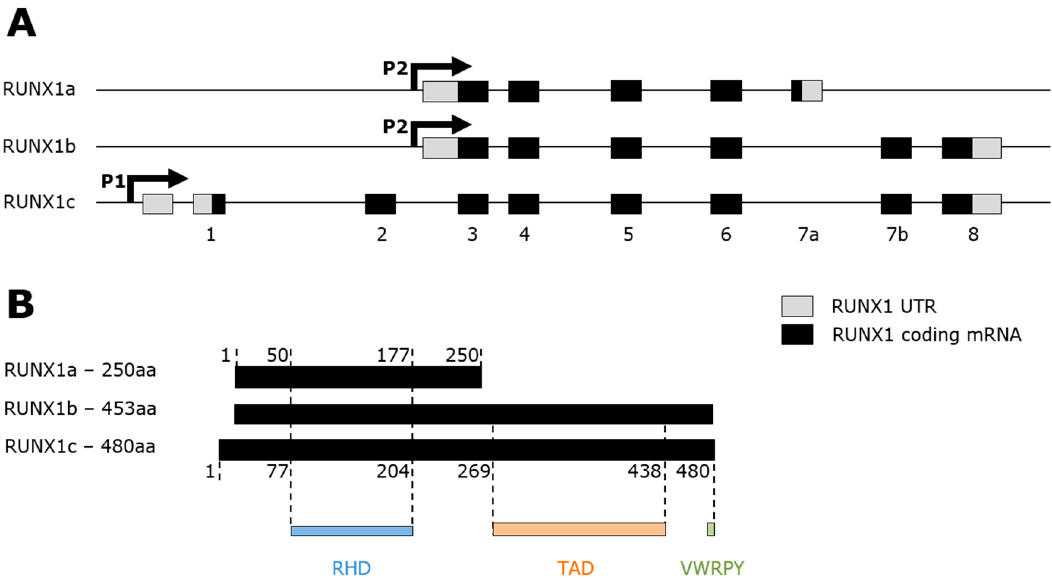
Figure 1. The three main RUNX1 isoforms, genomic locus and protein domains. ( A ) Schematic diagram of RUNX1a, RUNX1b and RUNX1c splicing variants on chromosome 21. RUNX1a and RUNX1b are transcribed from the P2 promoter and contain respectively 5 and 6 exons. RUNX1c is transcribed from the P1 promoter and contains 8 exons. ( B ) Schematic diagram of RUNX1a, RUNX1b and RUNX1c protein products from the alternative splicing and their protein domains. RUNX1a contains only the RHD whereas RUNX1b and RUNX1c contain the RHD, TAD and VWRPY motif.